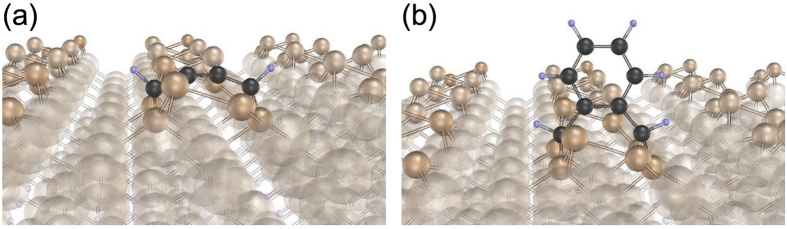
Influence of a dimer vacancy defect on the graphene growth.(a) C4H2 and (b) C8H6 molecules inside a dimer vacancy defect on Ge(001)-p(2 × 2).